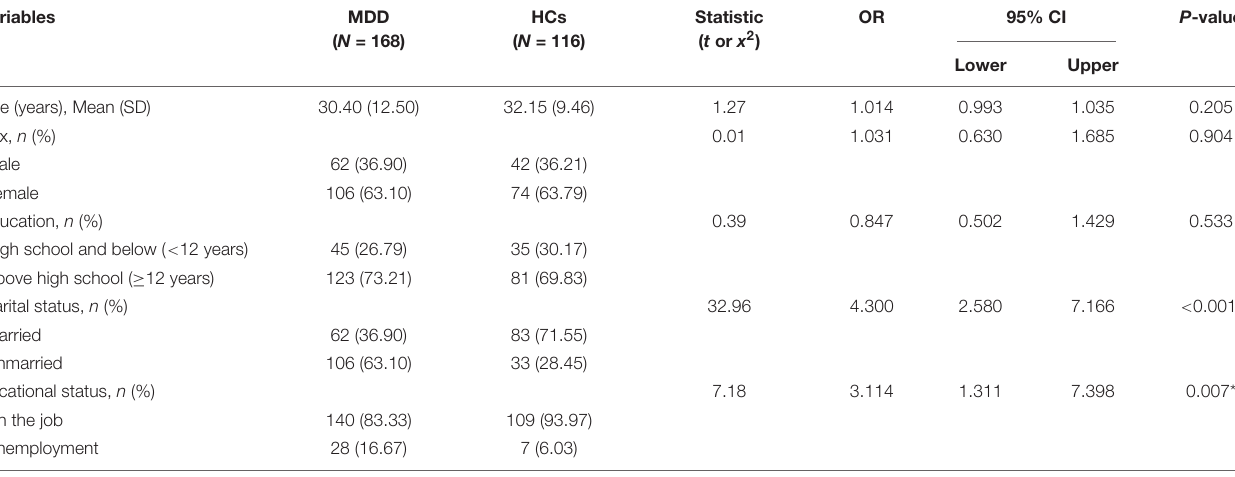
TABLE 1 | Comparisons of demographic characteristics between patients with MDD and HCs.